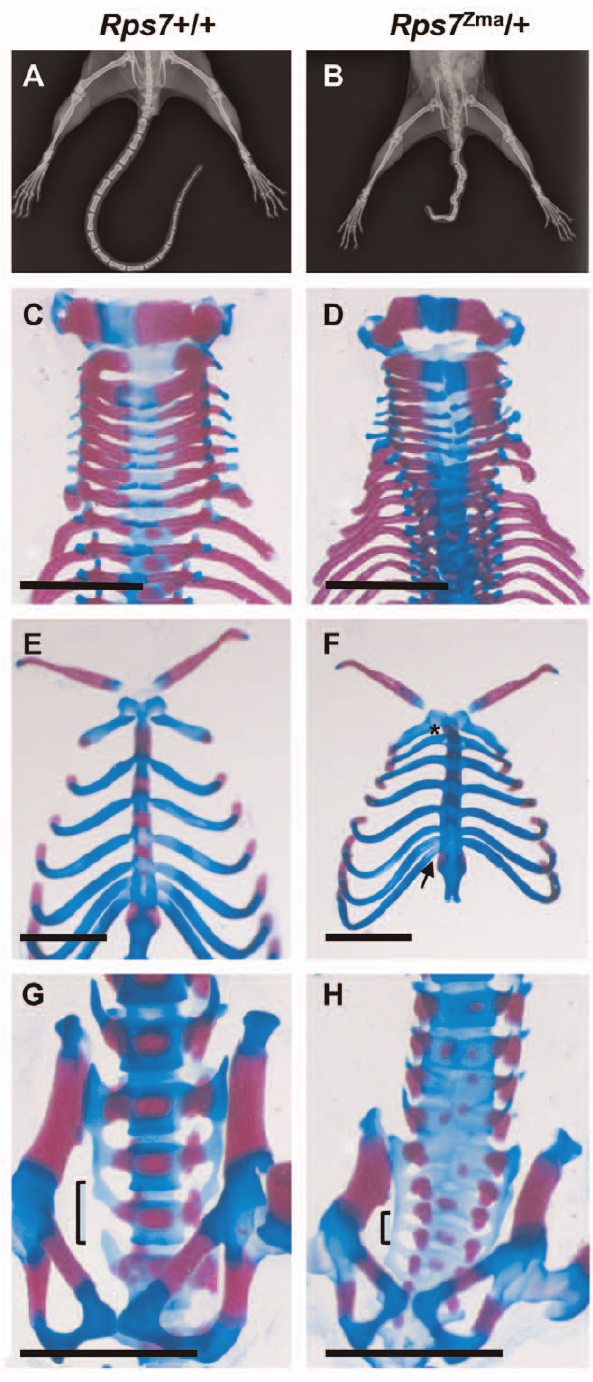
Figure 3. Skeletal abnormalities in Rps7 mutants. (A, B) Comparative X-rays of adult Rps7 + / + (A) and Rps7 Zma / + (B) mice show severe vertebral fusion leading to tail kinking in an Rps7 Zma / + mutant. (C–H) Alcian blue and alizarin red skeletal staining of late gestation Rps7 + / + (C, E, G) and Rps7 Zma / + (D, F, H) embryos. (C, D) Disorganization within the neural arches of Rps7 Zma / + is evident in a dorsal view of the cervical vertebrae. (E, F) Asymmetric attachment of 8 ribs to the sternum (arrow) and a shortened first sternebrae (*) are indicated in Rps7 Zma / + . (G, H) Delayed development and disorganization of the ossification centers is apparent in the lumbar and sacral vertebrae. The sacral vertebrae show abnormal fusing of additional vertebrae (bracketed region). Scale bars: C,D,G,H=2 mm; E,F=200 m